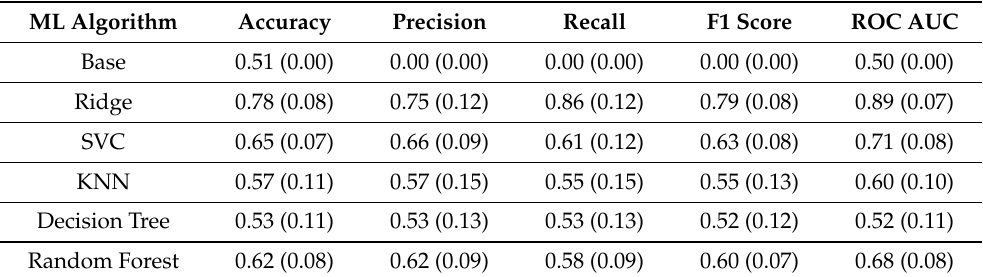
Table 7. EO prediction results (classification problem) using U-F features. Nested cross-validation with 10 outer and five inner splits. Classification problems on two classes: (a): High_EO (High Eudaimonic Orientated) and (b): Low_EO (Low Eudaimonic Oriented). Numbers are the mean value of 10 outer splits. Numbers in parenthesis indicate the standard deviation values.